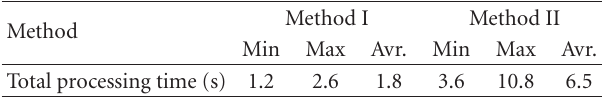
Table 3: Measuring point arrangement. Number of Location arrangement measuring points